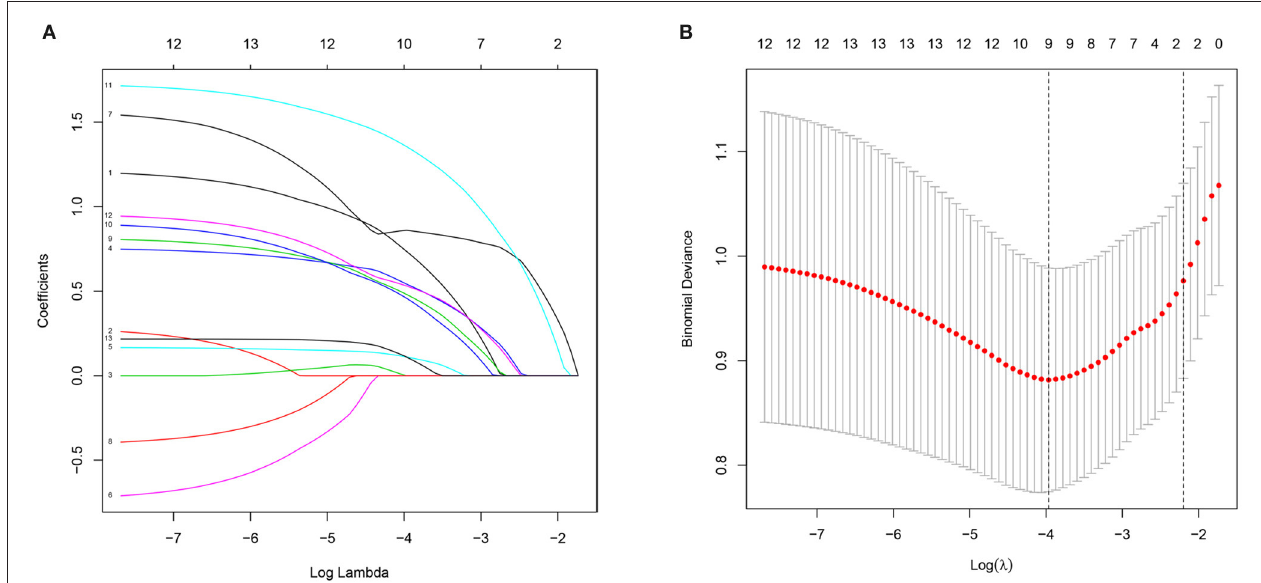
FIGURE 1 | Demographic and clinical feature selection using the LASSO binary logistic regression model. (A) LASSO coefficient profiles of the 12 features. A coefficient profile plot was produced against the log (lambda) sequence. Vertical line was drawn at the value selected using fivefold cross-validation, where optimal lambda resulted in nine features with non-zero coefficients. (B) Optimal parameter (lambda) selection in the LASSO model used fivefold cross-validation via minimum criteria. The partial likelihood deviance (binomial deviance) curve was plotted vs. log (lambda). Dotted vertical lines were drawn at the optimal values by using the minimum criteria and the 1 SE of the minimum criteria (the 1-SE criteria).